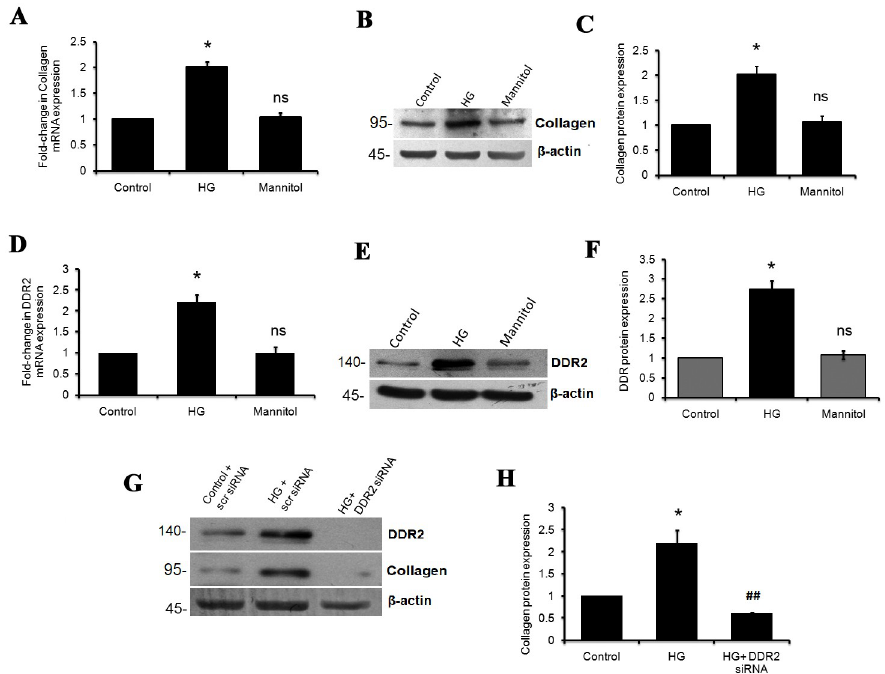
Fig 1. HG enhances collagen type I and DDR2 gene expression in vascular adventitial fibroblasts. Sub-confluent quiescent cultures of vascular adventitial fibroblasts in M199 were stimulated with HG (25mM). (A) Collagen type I alpha 1 mRNA levels were determined by Taqman Real-time PCR analysis at 6 h of HG treatment. 18S rRNA served as the endogenous control. � p < 0.05 vs. control, ns- not significant vs. control (One-way ANOVA p < 0.05). (B and C) Protein was isolated and subjected to western blot analysis for detection of collagen type I alpha 1, with β -actin as loading control. � p < 0.05 vs. control, ns- not significant vs. control (One-way ANOVA p < 0.05). (D-F) Sub-confluent quiescent cultures of vascular adventitial fibroblasts in M199 were stimulated with HG (25mM). (D) DDR2 mRNA levels were determined by Taqman quantitative real-time PCR analysis at 12 h of HG treatment, with β -actin as loading control. � p < 0.05 vs. control, ns- not significant vs. control (One-way ANOVA p < 0.05). ( E and F) Protein was isolated and subjected to western blot analysis for detection of DDR2, with β -actin as loading control. � p < 0.05 vs. control, ns- not significant vs. control (One–way ANOVA p < 0.05). ( G and H) Regulatory relationship between DDR2 and collagen type I in HG-treated adventitial fibroblasts. Adventitial fibroblasts were transiently transfected with DDR2 siRNA or scrambled siRNA. Following exposure of the transfected cells to HG for 12 h, collagen type I alpha 1 protein expression was examined by western blot analysis and normalized to β -actin. � p < 0.05 vs. control, ## p < 0.01 vs. HG (One-way ANOVA p < 0.05). Data are representative of three independent experiments, n = 3. Error bars represent